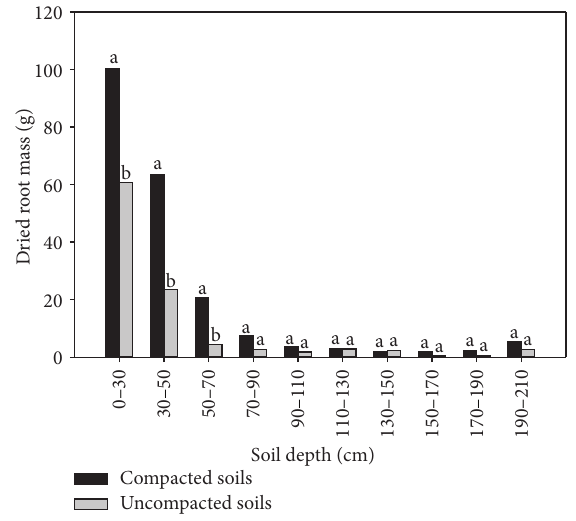
Figure 1: Root biomass of Quercus petraea L. at different depths in compacted and uncompacted reclaimed post-lignite mining soils. Different letters for the same depth indicate significant difference between root biomass in compacted and uncompacted soils ( 𝑃 < 0.05 ; Fisher LSD